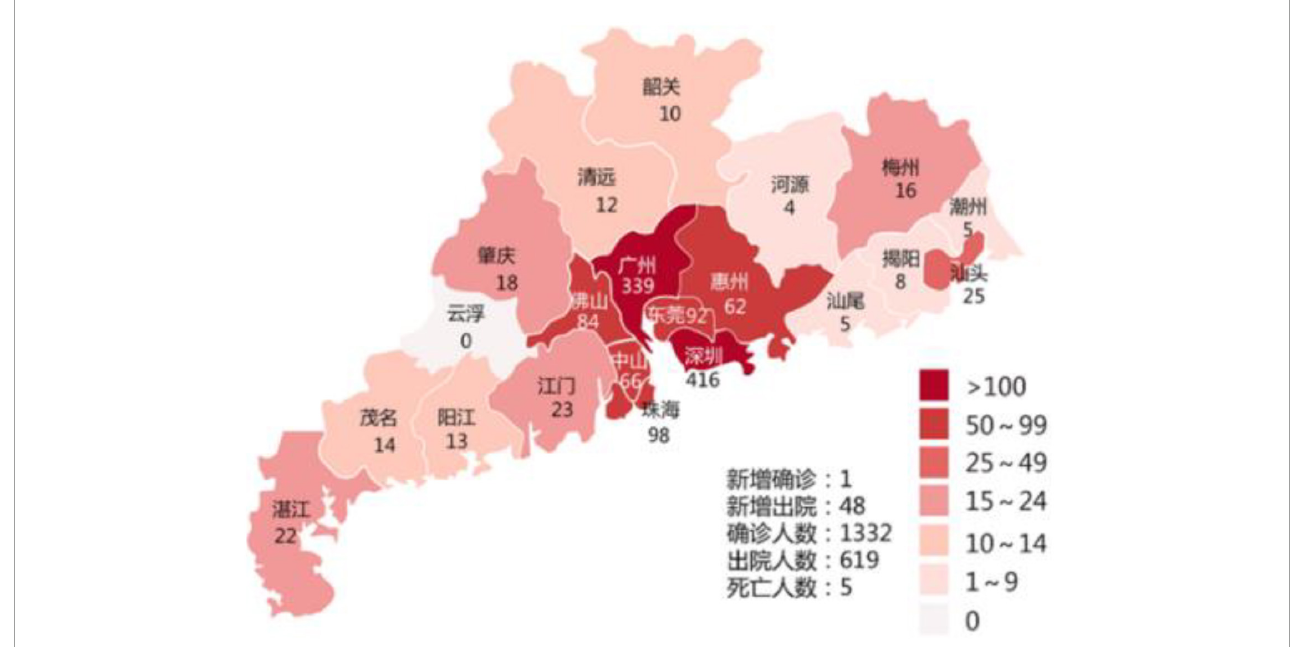
FIGURE4 Example of an outbreak chart.